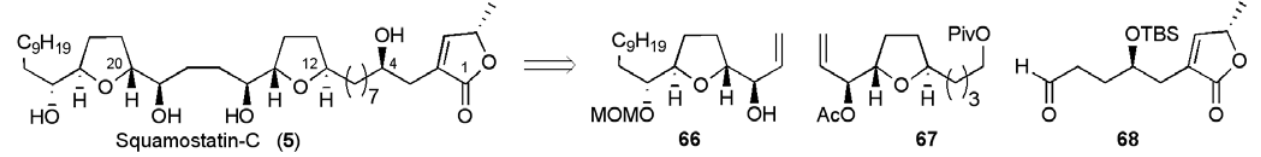
Figure 10. Mootoo’s route to squamostatin-C ( 5 ) using cross-metathesis to form the non- adjacent bis-THF